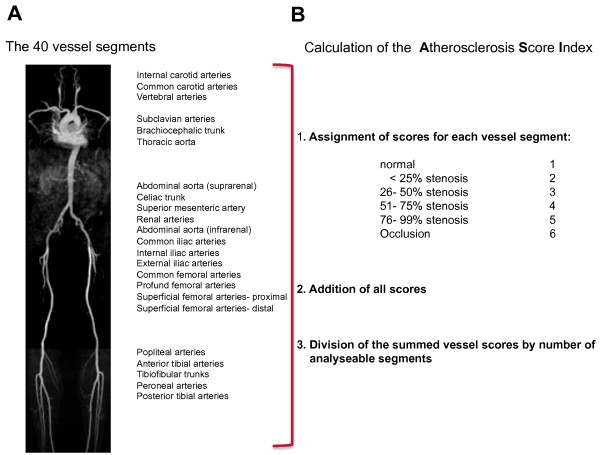
Evaluation of WB-MRA. Panel (A) shows an example for a fused whole body-MRA in a maximum intensity projection (MIP), the evaluated vessel segments are listed on the right. The ASI for each patient was calculated according to (B). The ASI in this example is 1.16.